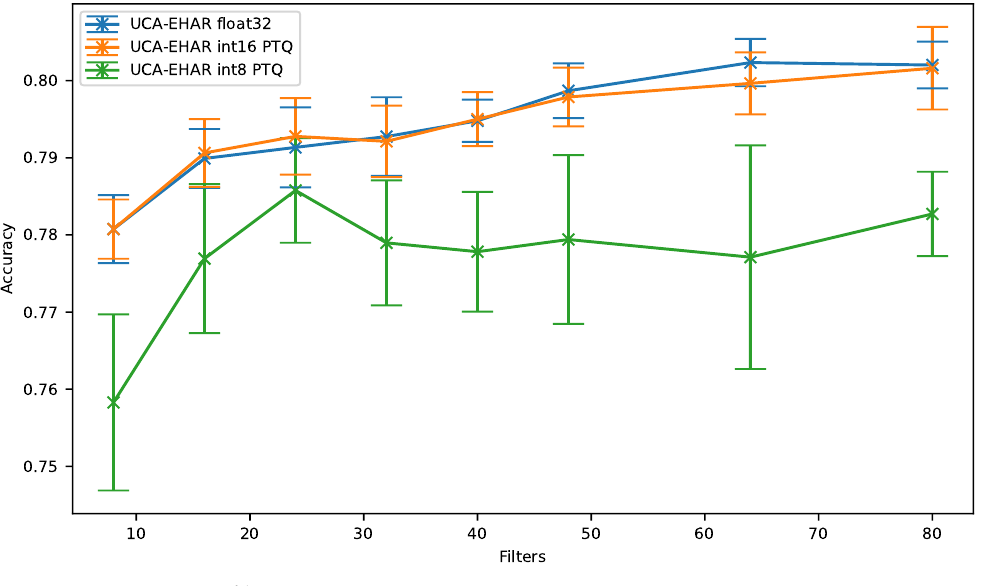
Figure 5. Accuracy vs.